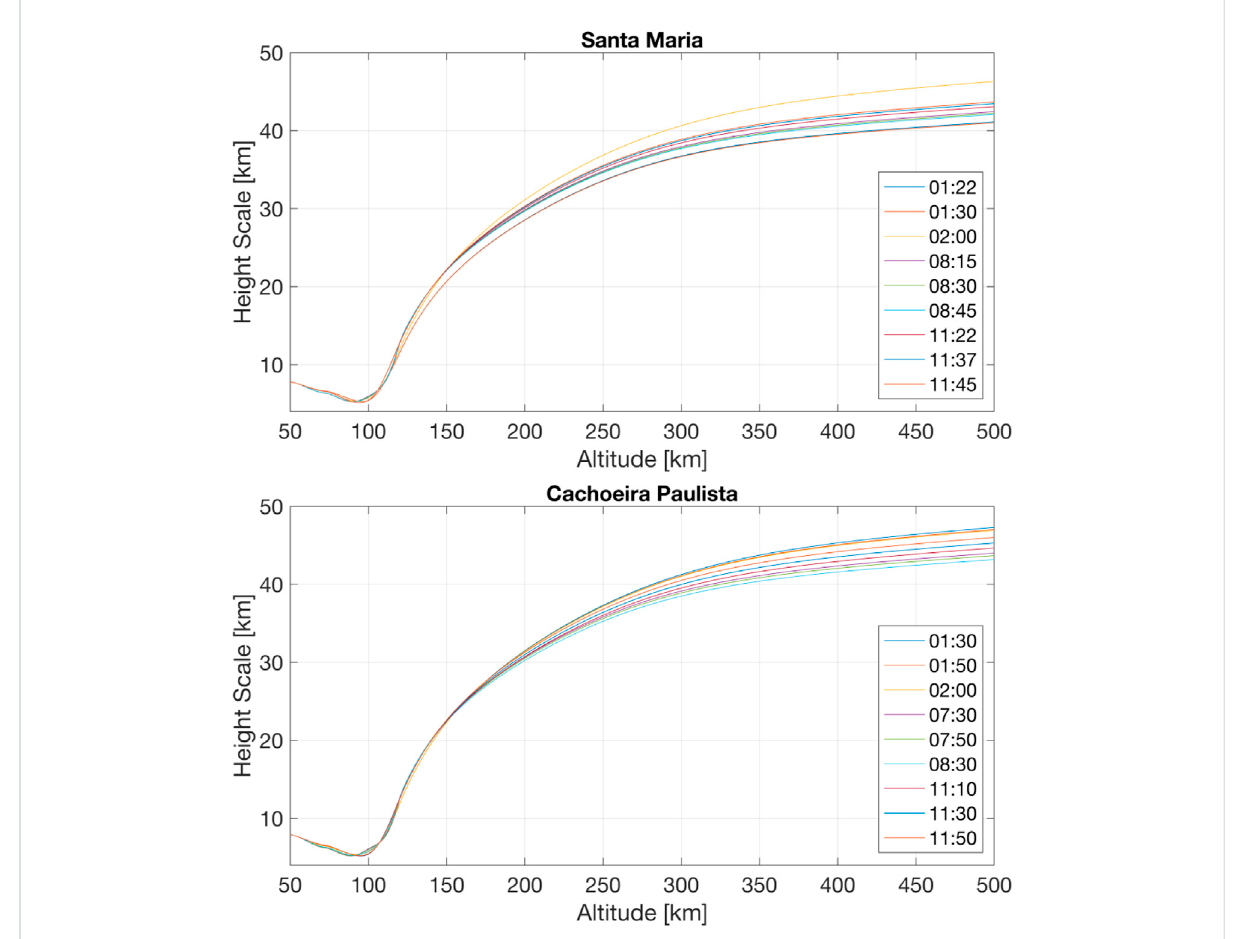
FIGURE 15 Height scale (km) for Santa Maria (top) and Cachoeira Paulista (bottom) stations, considering the three